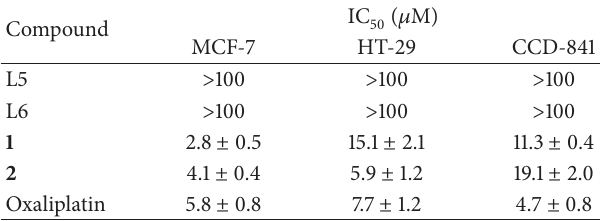
Table 2: Inhibitory concentration (IC and 2 compared to oxaliplatin toward two human tumor cell